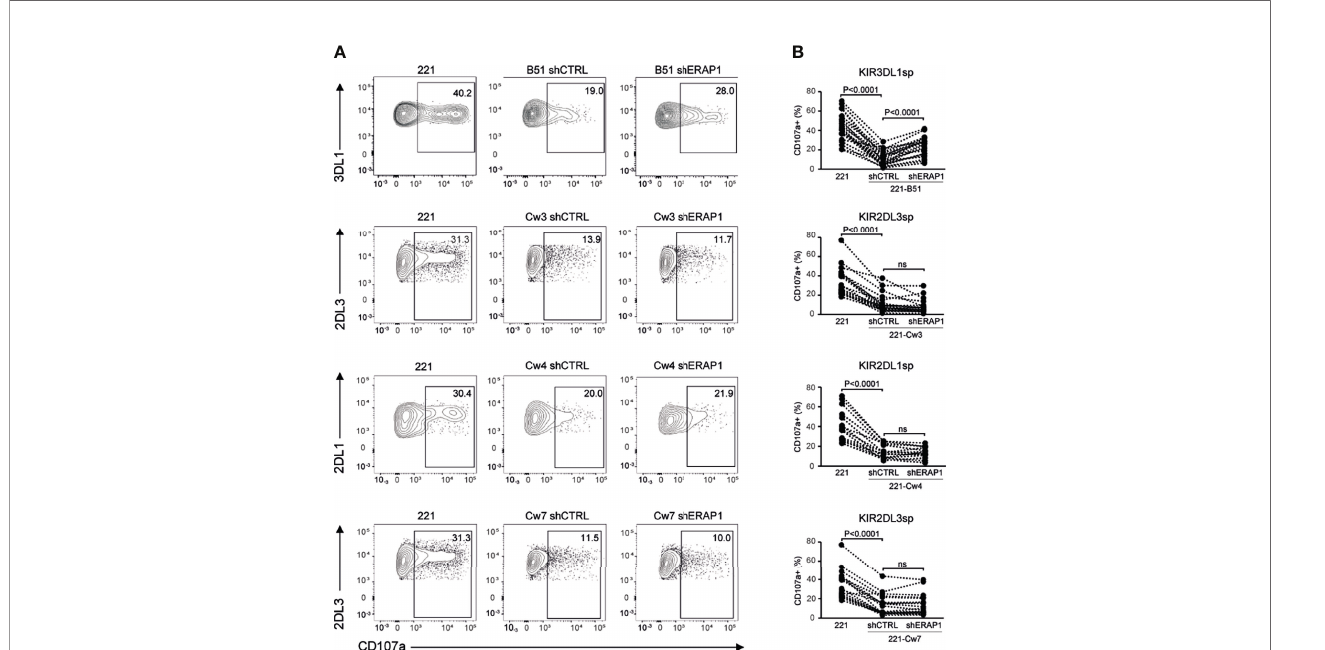
FIGURE 4 | Inhibition of ERAP1 enhanced NK cell killing of 221-B*51:01 cells by affecting the engagement of KIR3DL1. (A) , Example of degranulation by human CD56 + NK cells from one healthy donor co-expressing KIR2DL1, KIR2DL3, and KIR3DL1; CD107a cell surface expression was measured in speci fi c KIR single positive (KIRsp) subsets (KIR3DL1sp for 221-B51 cells, KIR2DL1sp for 221-Cw4 cells and KIR2DL3 for 221-Cw3 and -Cw7 cells) in response to ERAP1-inhibited 221 transfectants and control cells. The percentage of CD107a + cells within the indicated NK cell subsets is shown. (B) , Summary of NK cell degranulation in the indicated KIRsp NK subsets from healthy donors after stimulation with 221 parental and transfectant cells in response to ERAP1 inhibition. P values, calculated by two-tailed paired Student ’ s t -test. ns, not signi fi